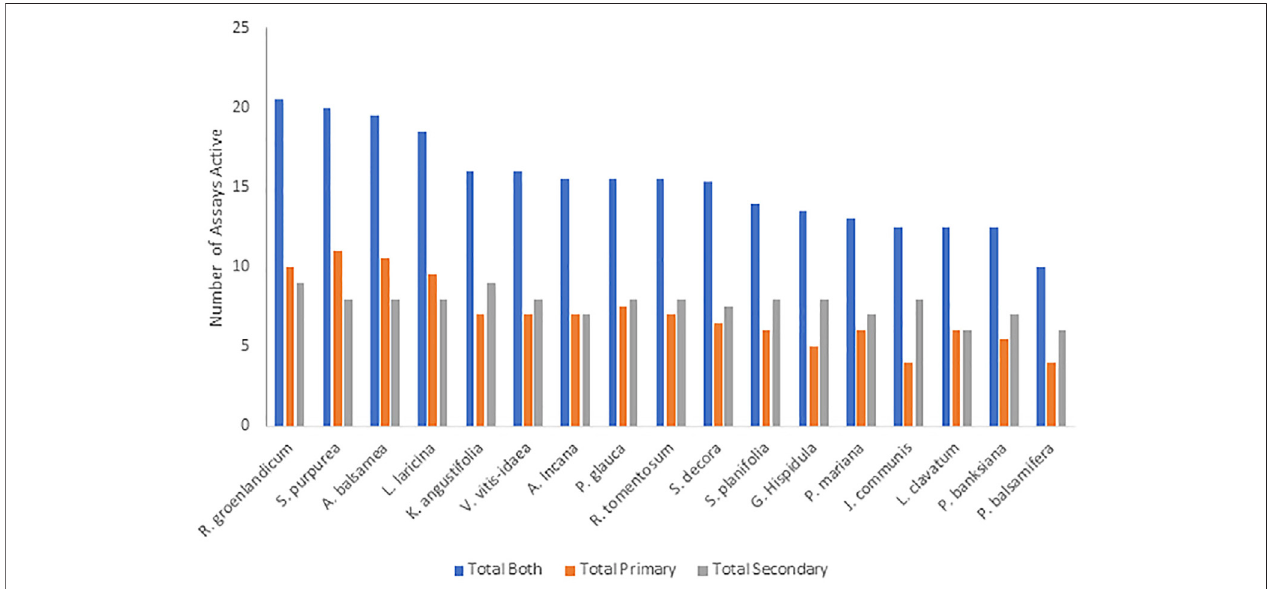
FIGURE 4 | The total number of assays for which Cree medicinal plants were determined to have statistically signi fi cant activity on bioassays evaluating effects on primary and secondary anti-diabetes bioassays. All species were tested on the same set of assays.